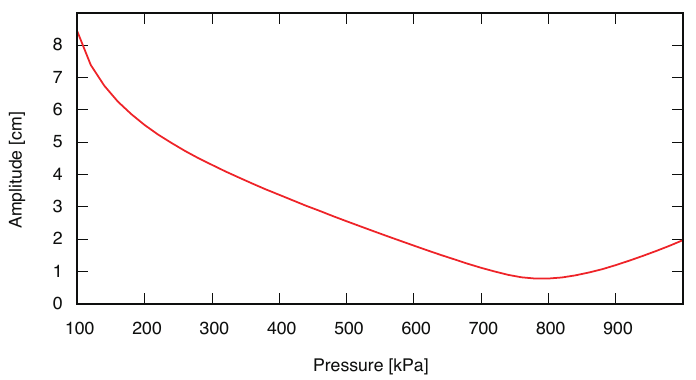
Figure 6. The changes in amplitude of motor position when desired mass position is the periodic movement given by p ( t ) = 0.3 + 0.01sin ( 80 t )